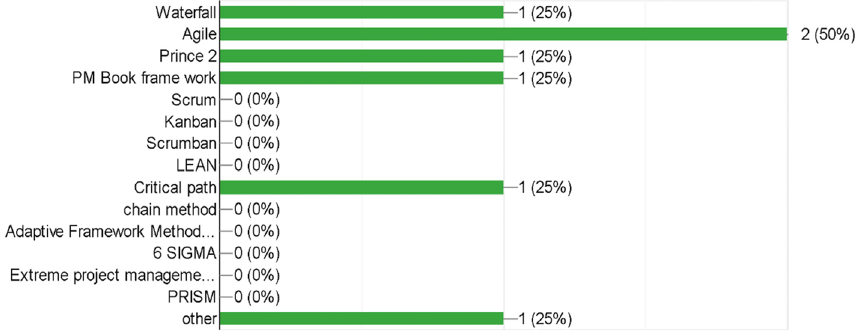
Fig. 4 Project management methodologies most commonly used in green building projects. Ref: